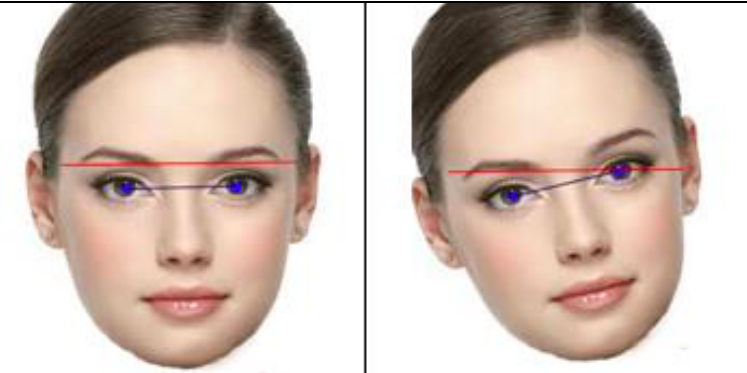
Figure 12. Face Figure 12. Face alignment.